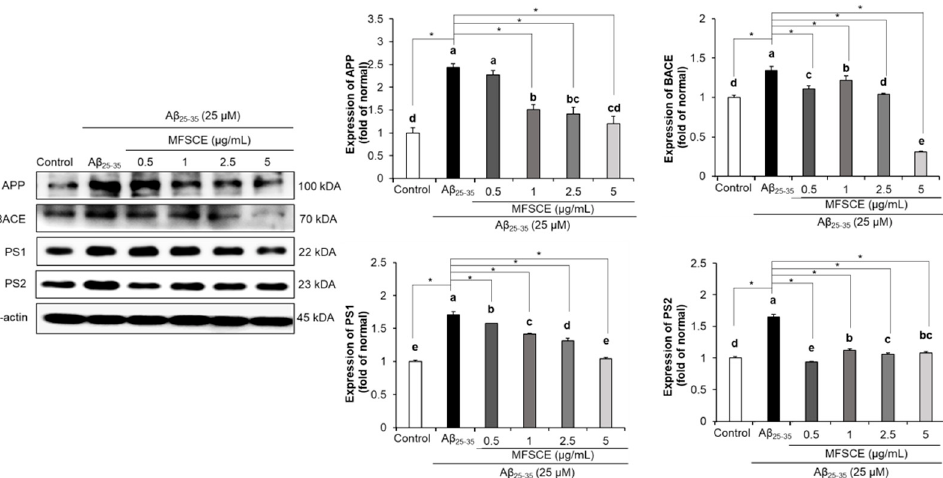
Figure 6. Effect of membrane-free stem cell extract (MFSCE) on expression of amyloidogenic pathway-related proteins in SH-SY5Y cells treated with A β 25–35 . β -actin was used as a loading control. Values are presented as mean ± SD ( n = 6). The different letters (a–e) among groups represent significant differences determined by ANOVA and Duncan’s multiple range test (p < 0.05). * p < 0.05 vs. A β 25–35 -treated cells.